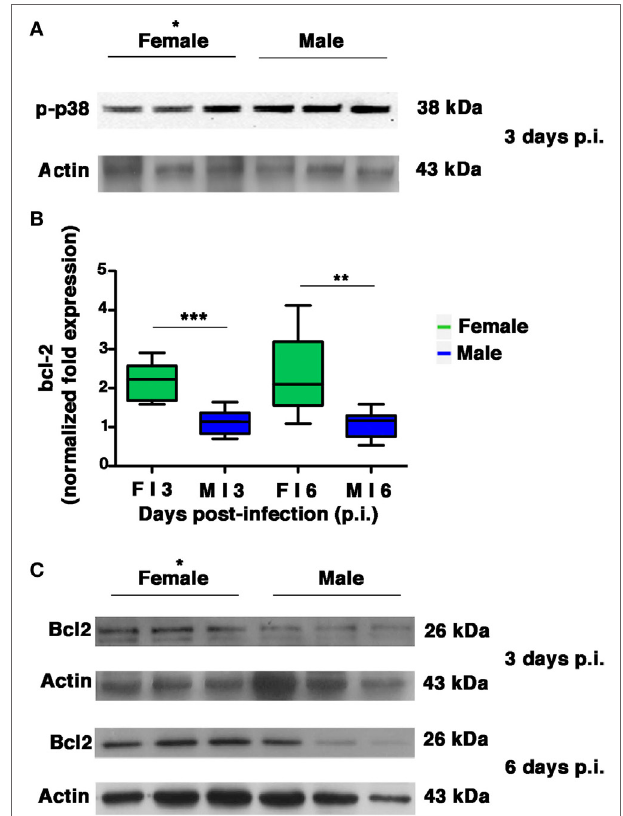
FigUre 8 | Female mice respond to PR8 infection with marked upregulation of Bcl-2 expression. (a) p-p38MAPK expression was analyzed by western blotting in the lungs of infected female and male mice at 3 days p.i. (three animals for each sex, * p -value = 0.02). (B) RT-PCR quantification of bcl-2 gene expression in the lung homogenates of infected mice euthanized on p.i. days 3 and 6. Box-plots represent the fold increases relative to levels observed in mock-infected controls ( n = 8/sex), unpaired t -test ** p -value = 0.0018; *** p -value = 0.0002. (c) Bcl-2 protein expression was analyzed by western blotting in the lungs of infected female and male mice. Actin was used as loading control. Blots shown are one representative experiment of three performed (three animals for each sex, * p -value ≤